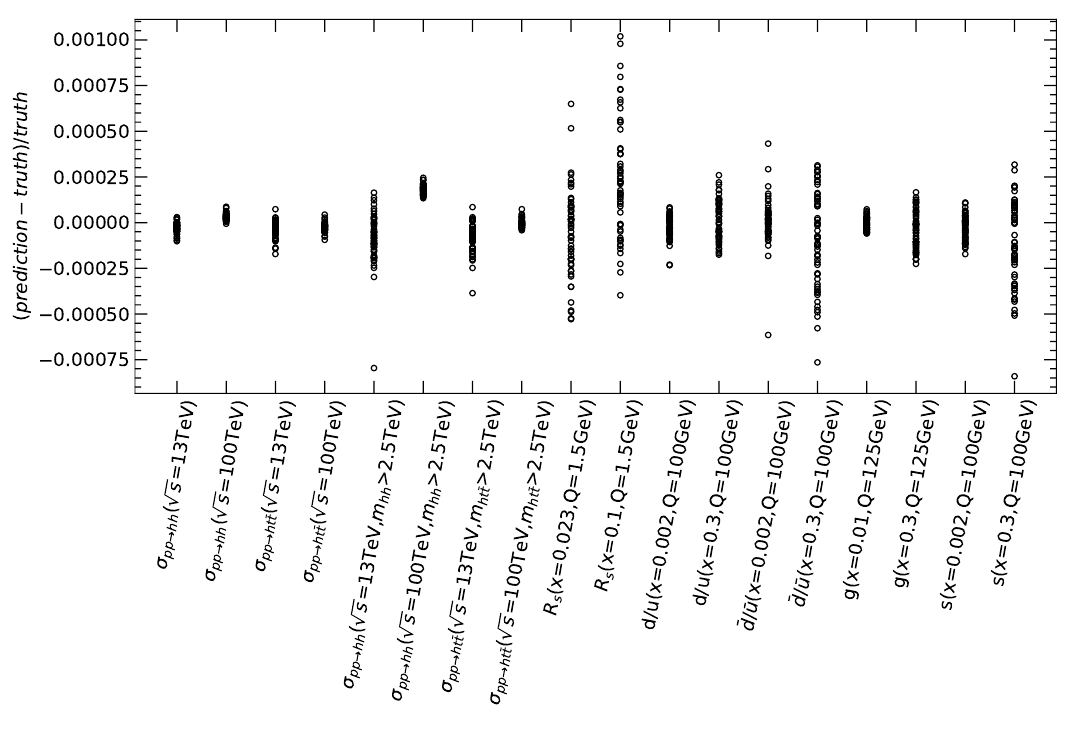
Figure 5 . The ratios of the predictions from NNs to the truths for the cross section of top-quark pair with a Higgs boson production in proton-proton collisions at a center of mass energy 13 TeV and the PDF ratio d/u ( x = 0 . 3 , Q = 100 GeV).